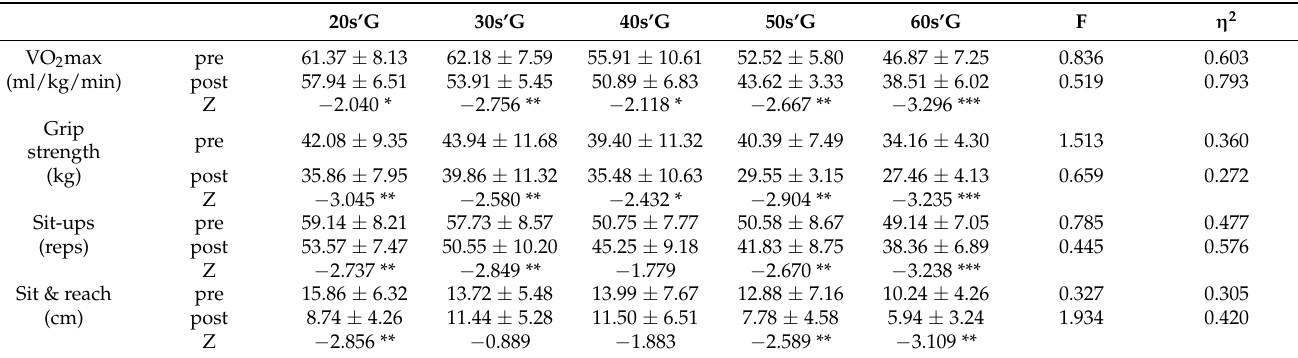
Table 3. Differences and changes in physical fitness among 5 groups.